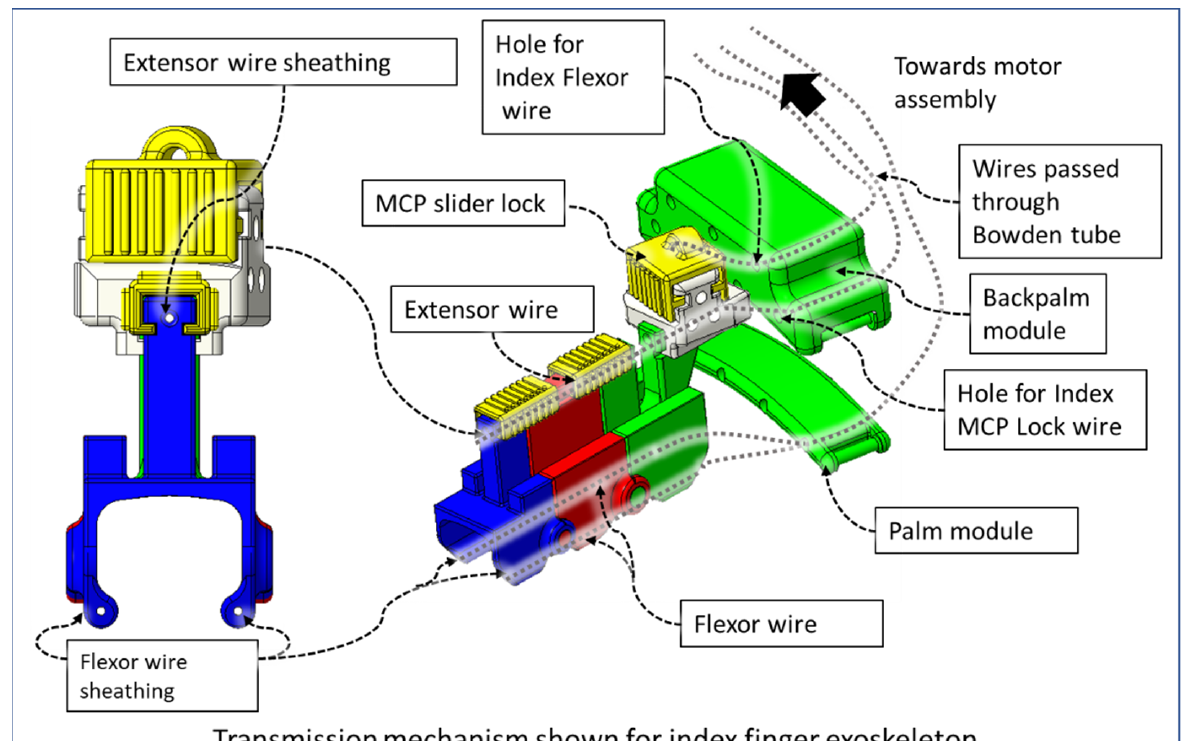
Figure 8. Cable-driven transmission mechanism of the device.